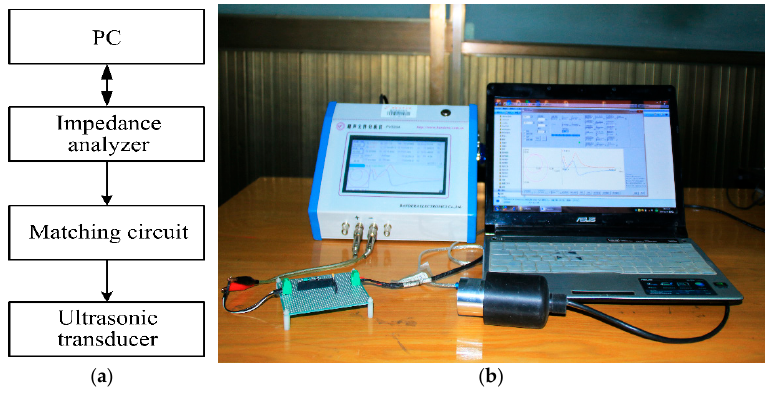
Figure 7. The impedance test of the single sandwiched piezoelectric ultrasonic transducer with EIM network, ( a ) the test platform diagram, ( b ) the test platform picture.